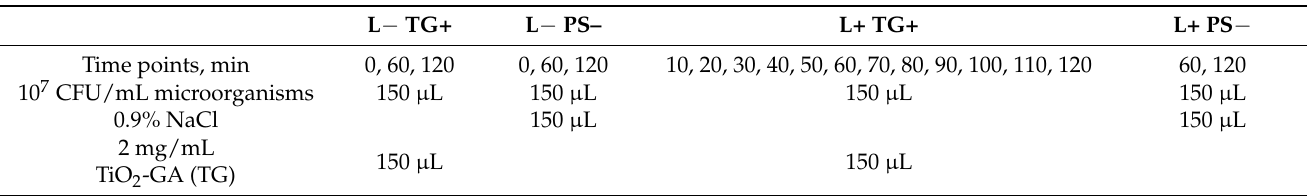
Table 2. Amounts of ingredients added to the wells of a microtiter plate during the experiment on S. aureus